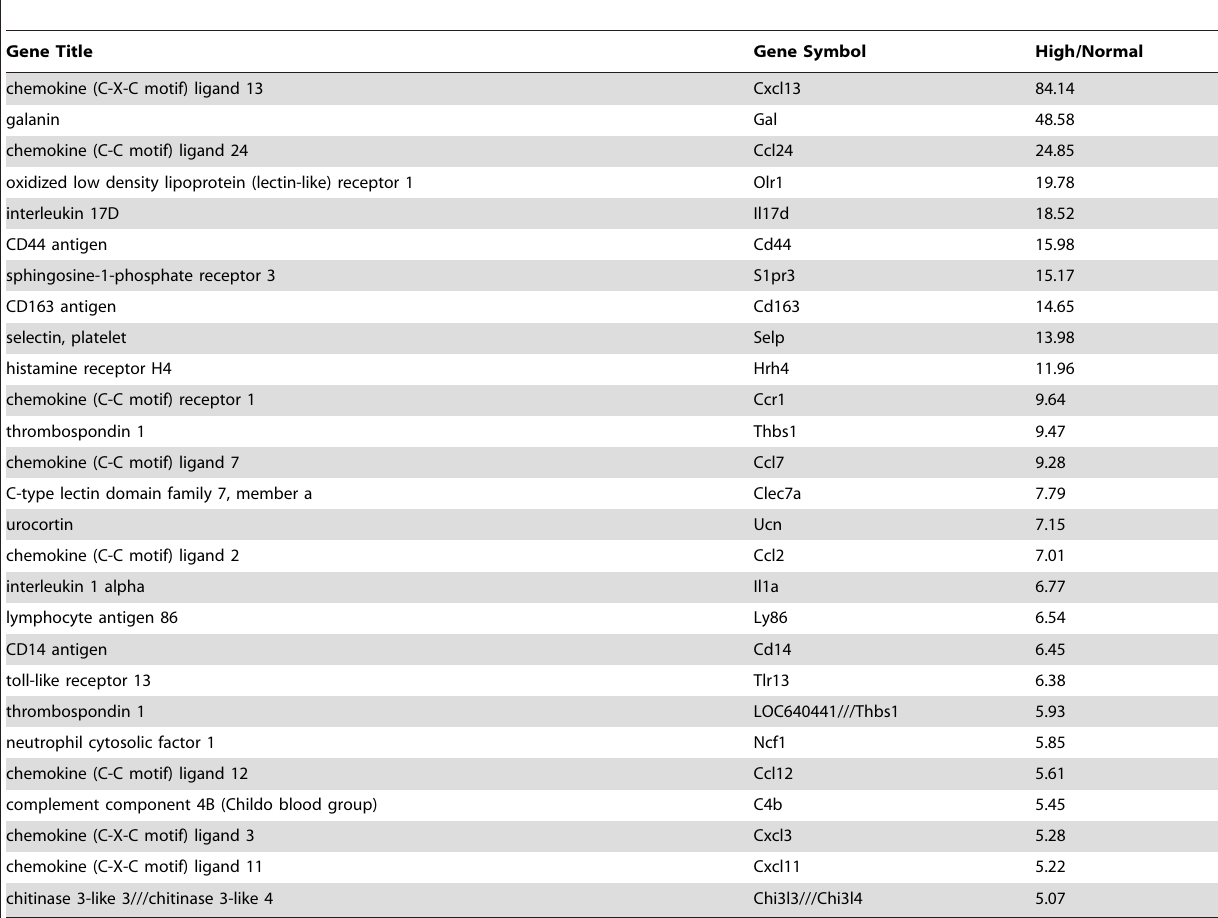
Table 3. Upregulated genes ( . 5-fold) classified as ‘chemotaxis